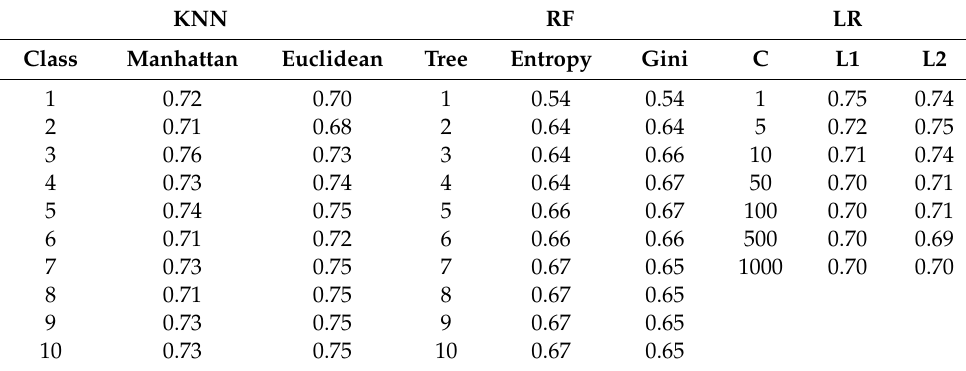
Table 3. Evaluation of KNN, RF, and LR